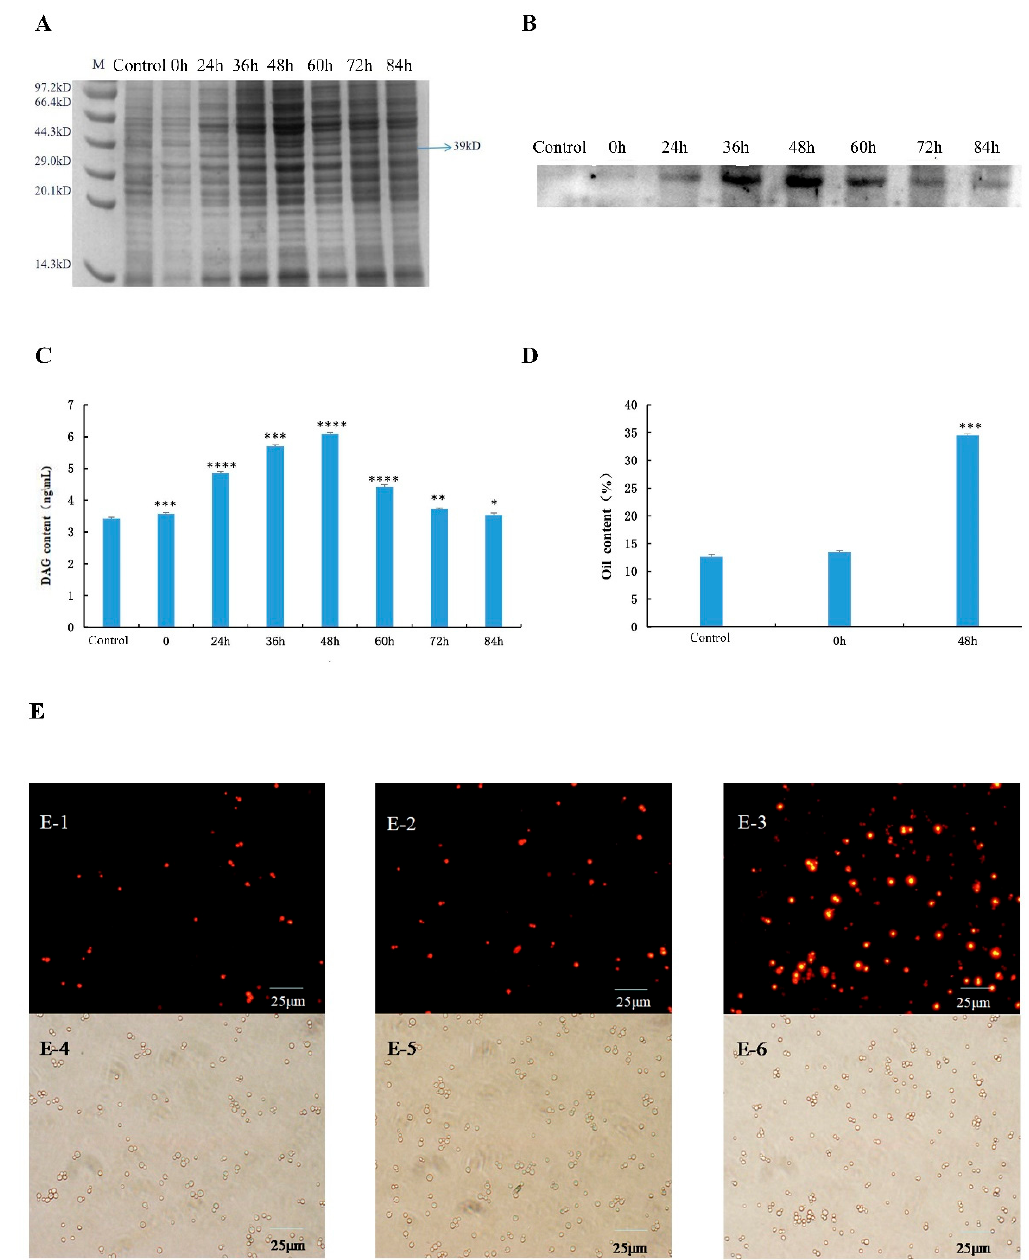
Figure 8. Functional verification of CePAH1 gene. ( A ) The expression of CePAH1 protein was detected by SDS-PAGE. ( B ) Western blot analysis of recombination protein at different induction time. ( C ) Content determination of DAG. ( D ) Detection of oil content in yeast cells at different induction time. ( E ) Neil red staining visualization of Yeasts cells under the fluorescence light ( E-1 – E-3 ) and ordinary light ( E-4 – E-6 ). ( E-1 , E-4) : Control, Yeast cells with pESC-URA plasmid; ( E-2 , E-5 ): Yeast cells were induced at 0 h; ( E-3 , E-6 ): Yeast cells were induced for 48 h.